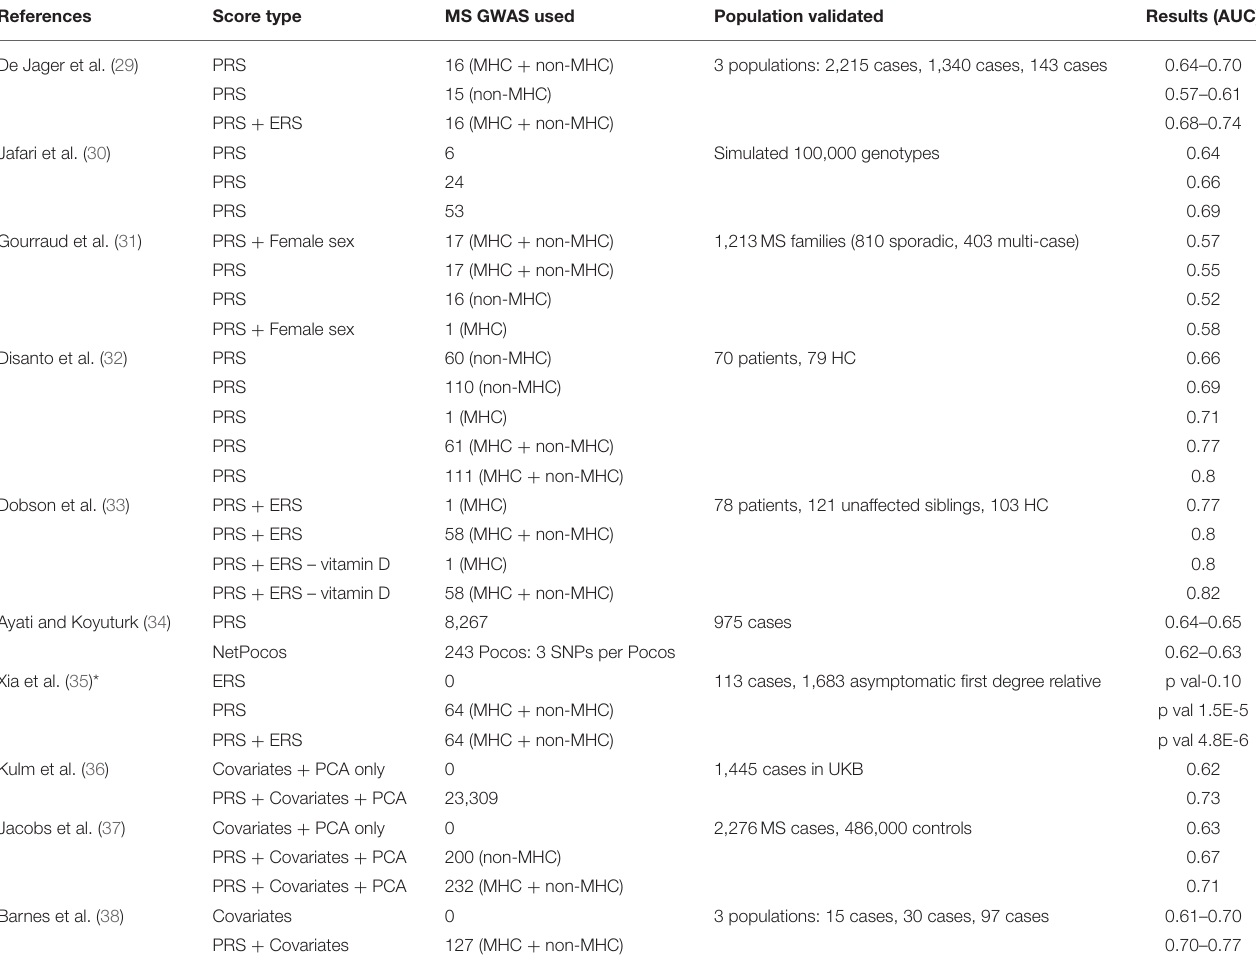
TABLE 1 | Comparison of PRS and ERS efforts in MS in